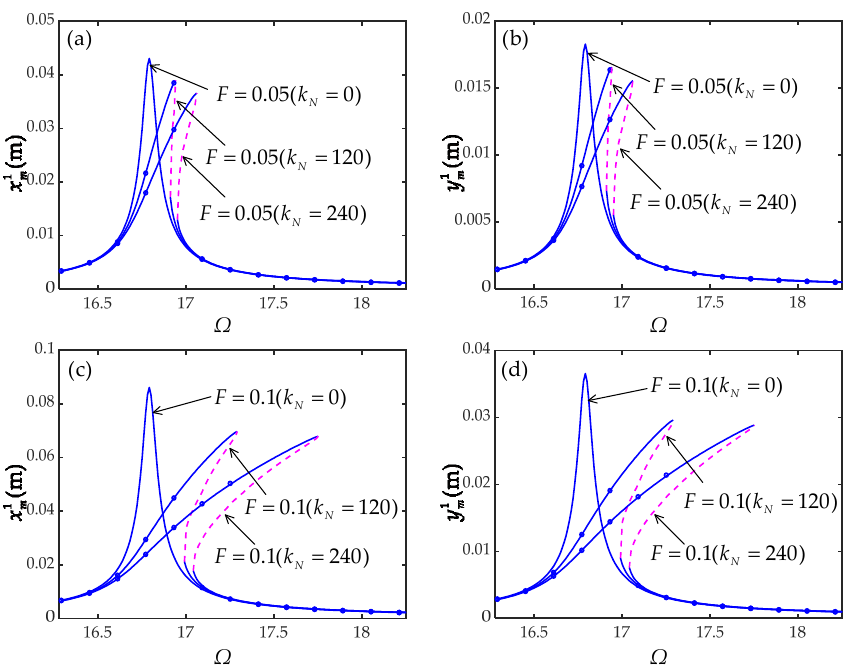
Figure 6. Frequency response curves for the first mode at Ω = ω 1 + εσ 2 and σ 1 = 0.01: ( a ): horizontal displacement for F = 0.05, ( b ): vertical displacement for F = 0.05, ( c ): horizontal displacement for F = 0.1, ( d ): vertical displacement for F = 0.1.